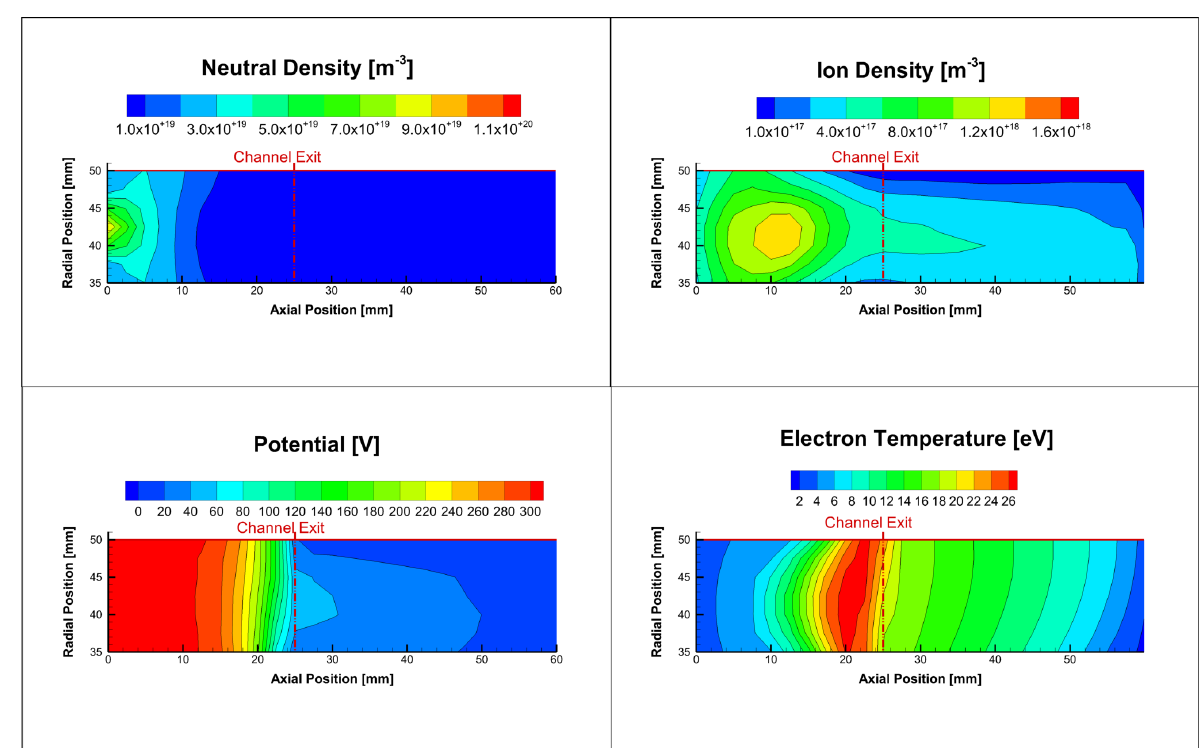
Figure 13. SPT-100 simulation: Test 95 . Time-averaged contour plots of neutral and plasma densities, potential and electron temperature. Average window: 1